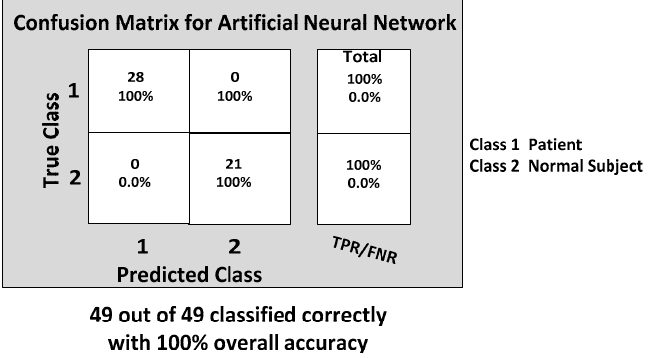
Figure 14. The final confusion matrix showing the gait classification results using the BP-ANN classification model with the true positive rate (TPR) and false positive rate (FPR).